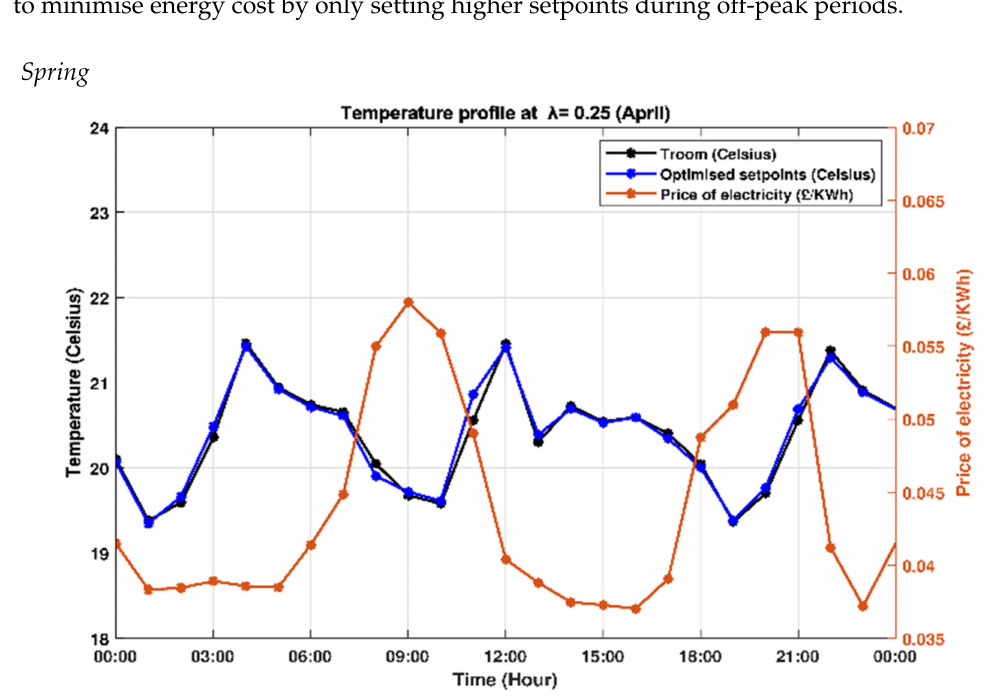
Figure 9. Room temperature and MPC-generated setpoints over 24 h using sample spring season price